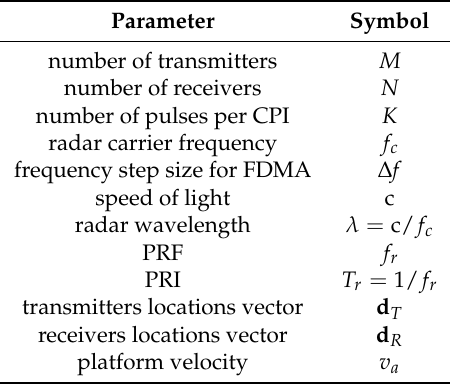
Figure 1. Illustration of the multiple-input multiple-output ground moving target indication radar. Table 1. Symbols for the multiple-input multiple-output ground moving target indication radar system